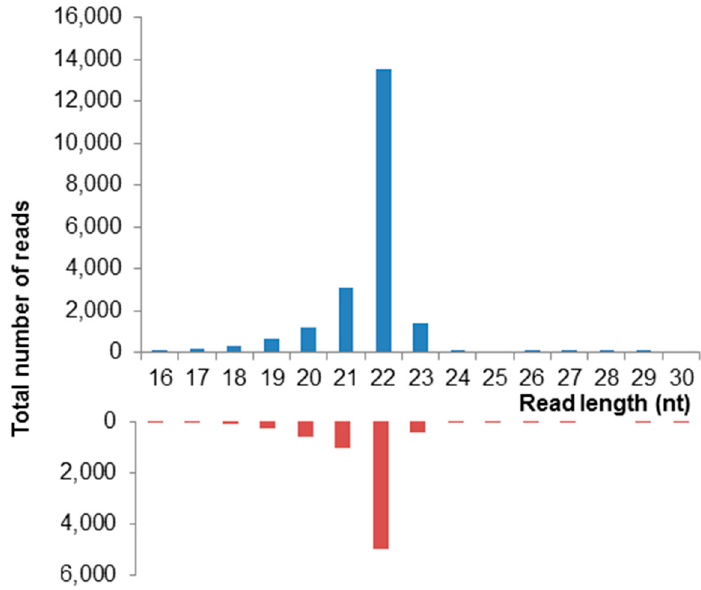
Figure 4. Virus ‐ derived small interfering RNA (vsRNA) sequences derived from the sense (blue) and anti ‐ sense (red) genome of ApGlV2. Reads were extracted from a small RNA sequencing dataset of A. glycines (Iowa) infected with ApGlV2 and an ALPV ‐ like virus. The majority of the ApGlV2 vsRNAs are 22 nt, characteristic of double ‐ stranded RNA processing by Dicer2.